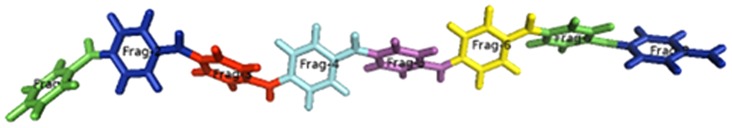
Fragmentation of Leucoemeraldine (a Polyaniline) using FragIt.This particular example uses no fragmentation patterns but rather explicitly defined points of fragmentation by the end user.